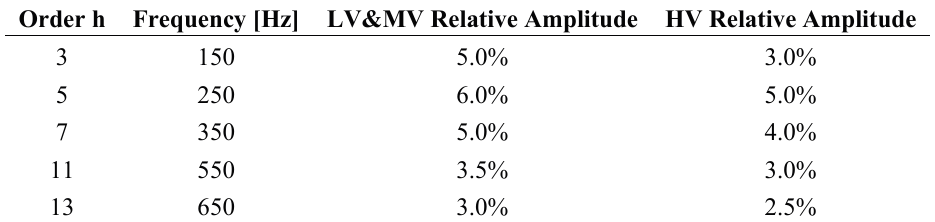
Table 1. Harmonic component considered in the magnetic field exposure scenario and their amplitude in terms of percentage of the amplitude of the fundamental component, as provided by the European standard EN